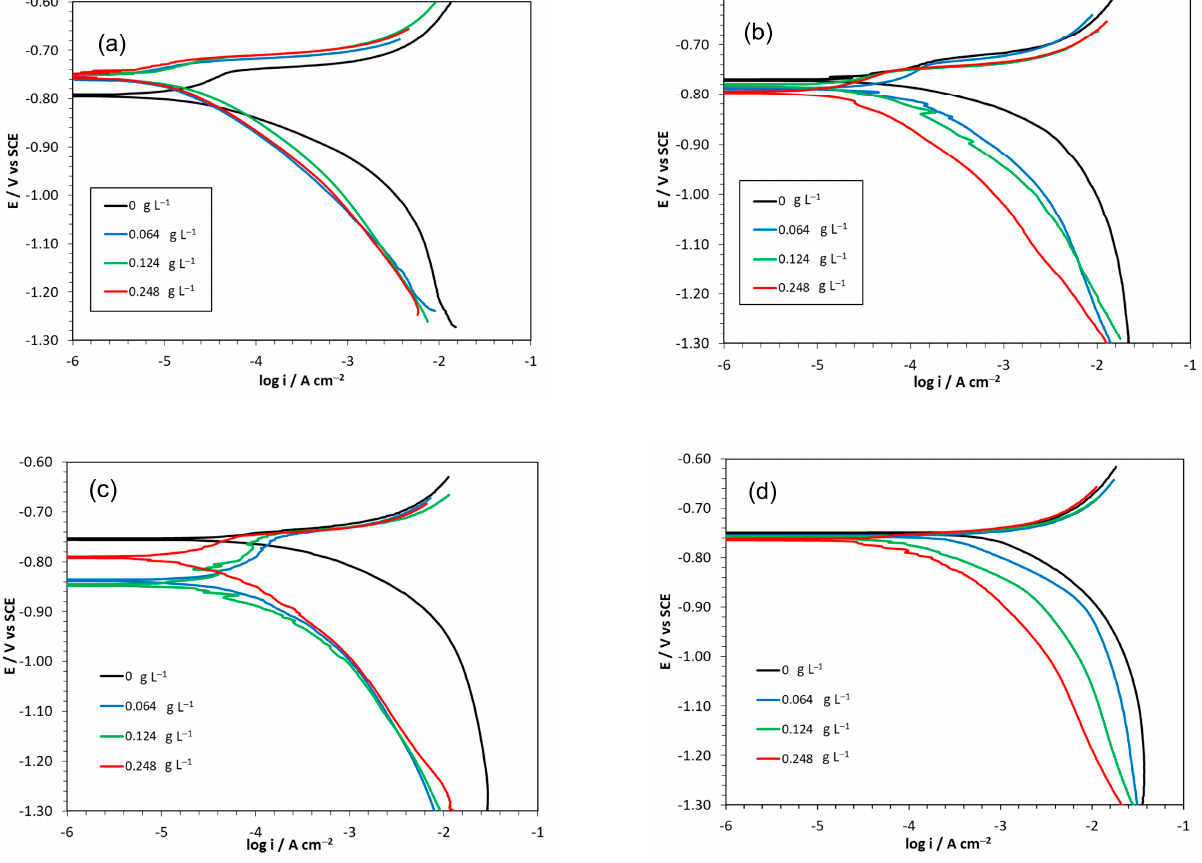
Figure 4. Effect of Ilex paraguariensis concentration on the polarization curves of the aluminum polarization in the blank solution and in inhibited solutions with different inhibitor concentrations at 298 K ( a ), 308 K ( b ), 315 K ( c ) and 323 K ( d ).